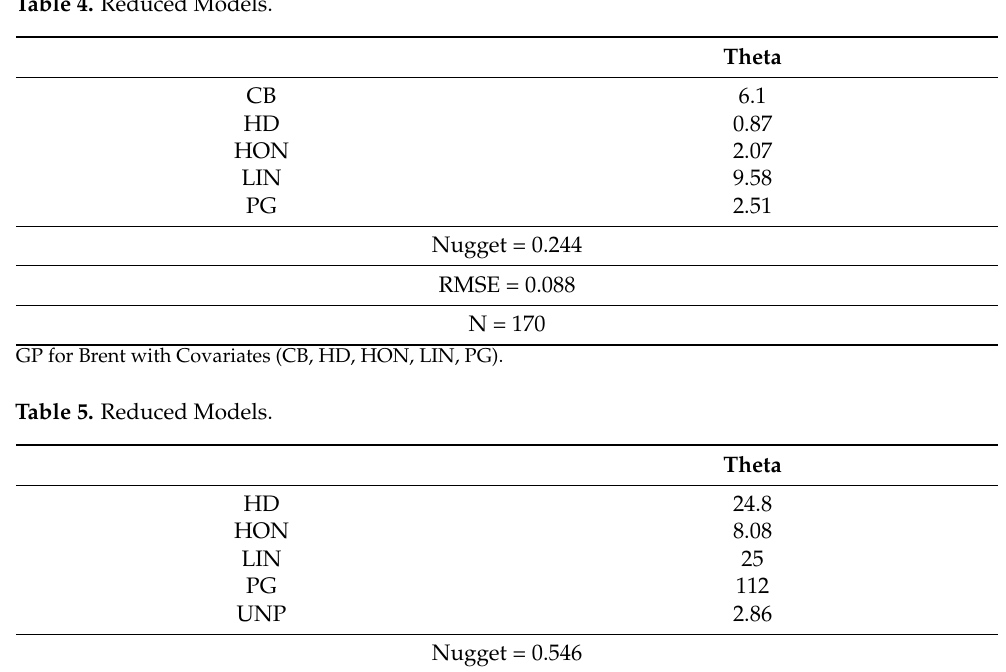
Table 4. Reduced Models.